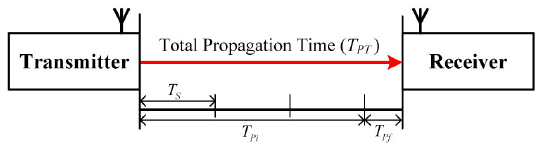
Figure 1. Configuration of total propagation time T PT of RF